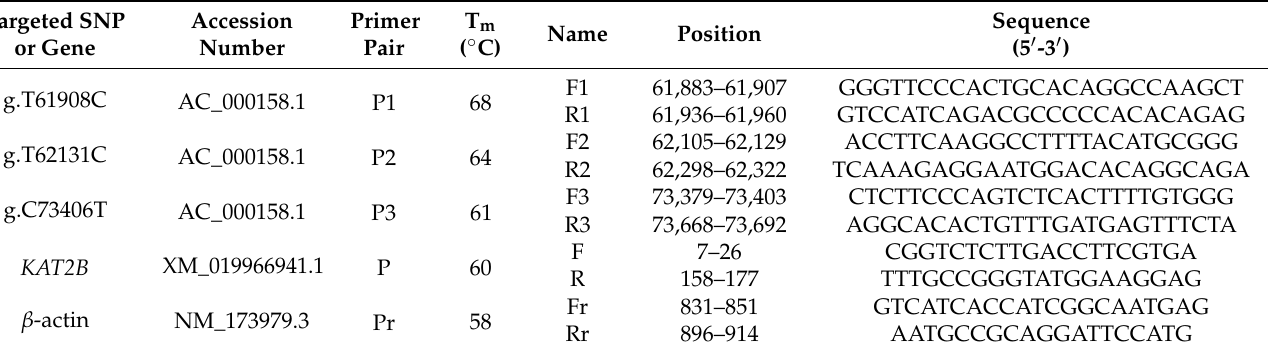
Table 1. Primers for PCR in this